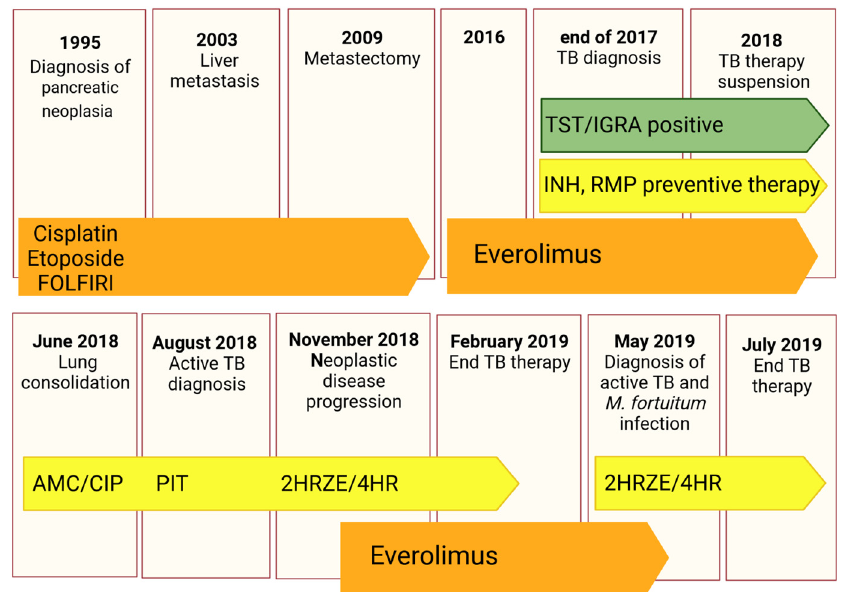
Figure 1. Schematic timeline reporting information on the clinical history of the patient, including microbiological examinations and treatments. Oncological therapies are reported in orange, while antibacterial ones in yellow and green boxes illustrate the immunological tests to diagnose Mtb contact. Antineoplastic drugs (Cisplatin, Etoposide, FOLFIRI regimen, and Everolimus), antibiotics (AMC: Amoxicillin/clavulanate; CIP: ciprofloxacin; and PIT: Piperacillin/tazobactam) and anti-TB treatments (INH: Isoniazid, RMP: Rifampicin, HRZE: Isoniazid/rifampicin/pyrazinamide/ethambutol, HR: isoniazid/rifampicin) are